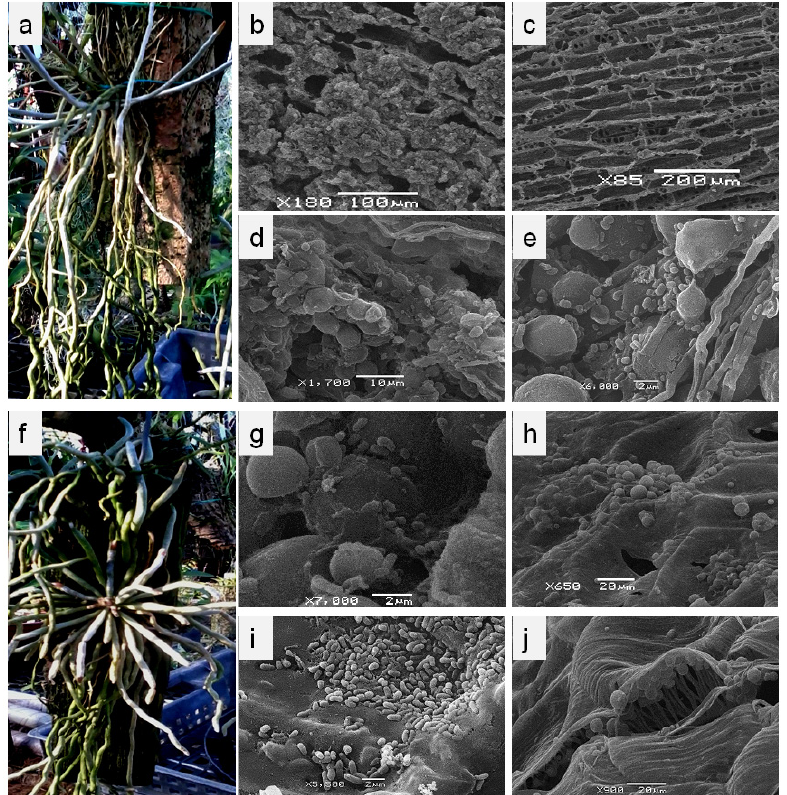
Figure 1. The leafless orchids, Chiloschista parishii and Microcoelia moreauae , grown under greenhouse conditions, and the scanning electron micrographs of their aerial roots. The plants mounted on the piece of wood ( a , f ); their numerous aerial roots are radially directed: the new and young roots are grayish/silvery due to the velamen radicum structure, whereas the adult roots are covered with the green biomass (biofilms) of the cyanobacterial microbial community. The micrographs of the root surface of C. parishii ( b , d , e ) and M. moreauae ( g – i ) with cyanobacterial filaments and bacterial cells, single and aggregated in populations (colonies), attached to the surface or adherent (plunged) into extracellular matrix of cyanobacteria; ( i ) bacterial microcolonies in the grooves of young roots. The velamen radicum of the aerial roots: ( c ) the longitudinal section through the root shows a structure and a number of the perforations typical for the mature velamen; ( j ) the inner layer of velamen with clusters of microorganisms inside it.